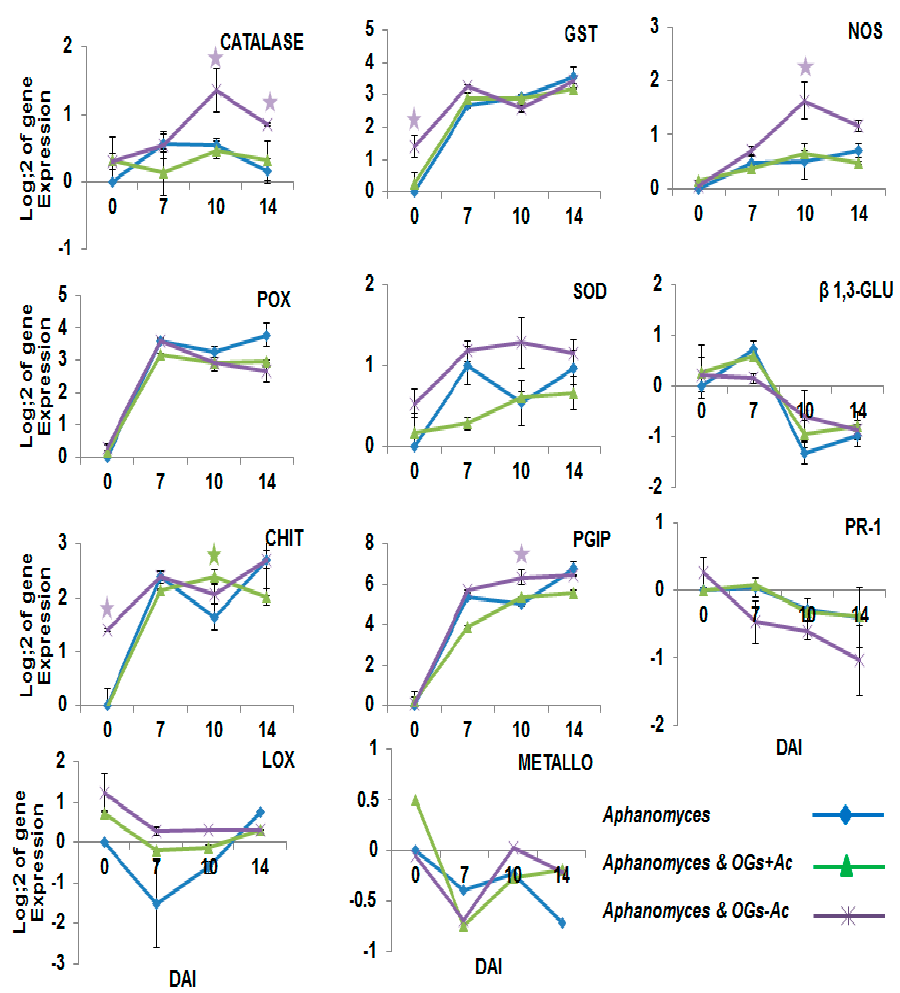
Figure 6. PAL gene expression ratio at 3, 6, 12, 24, 48, 96, 168 and 336 hours after treatment (hat) with water, 80 µg/plant of acetylated oligogalacturonides (OGs + Ac) or 200 µg/plant of nonacetylated OGs (OGs − Ac). The elicitor injections were done two weeks before inoculation (wbi) and two and one wbi for OGs − Ac and OGs + Ac, respectively. After inoculation with 10 5 Aphanomyces euteiches zoospores/plant, PAL gene expression was followed over the same time course (hours after inoculation (hai)). The values shown are means of five repetitions. ☆ Stars indicate gene induction ≥ 2-folds and significant differences between elicitor treatments and inoculated non-treated control according to the Tukey test ( p ≤ 0.05).